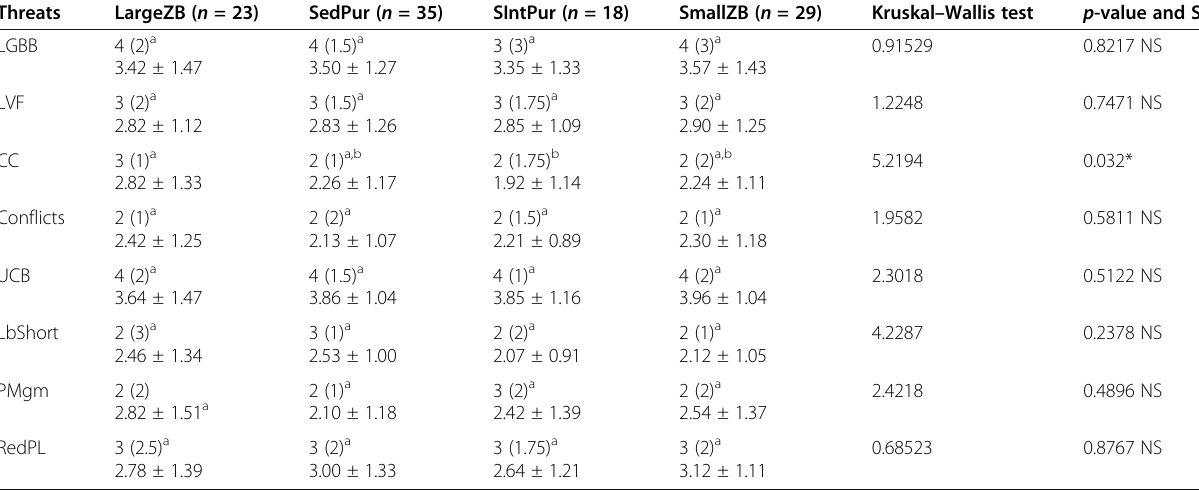
Table 2 Threat level from socio-environmental factors according to groups of farmers Threats LargeZB ( n = 23) Kruskal – Wallis